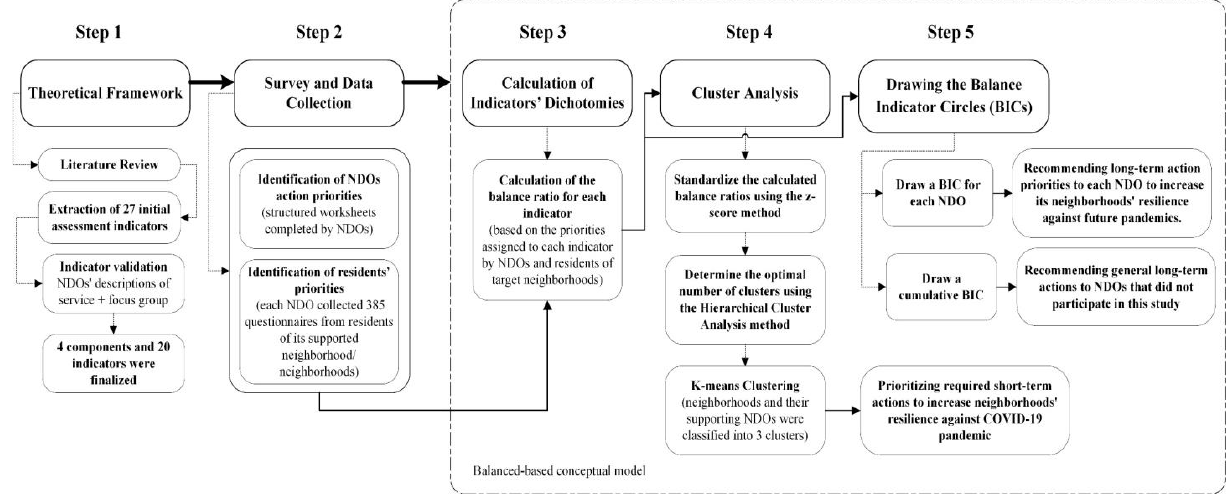
Figure 2. Research methodology steps. Table 1. Evaluation components and indicators.